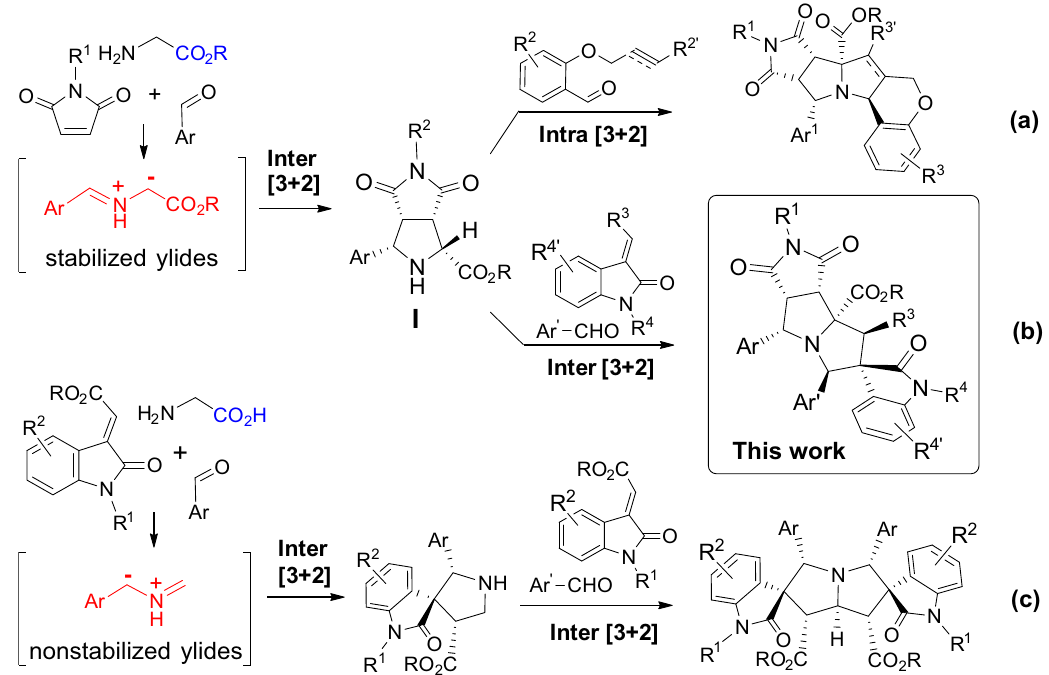
Scheme 1: Double [ 3 + 2 ] cycloadditions with di ff erent dipolarophiles: ( a ) reported synthesis in ref. [ 35 ] , ( b ) this work, and ( c ) reported synthesis in ref. [ 36 ]